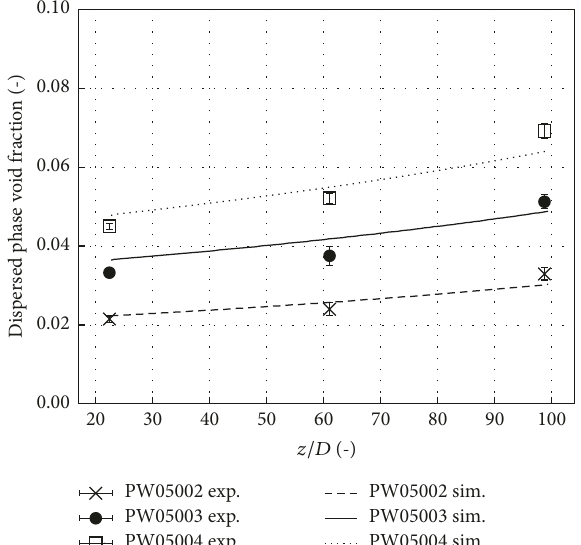
Figure 14: Comparison between computational results and experi- ments of the interfacial area concentration axial